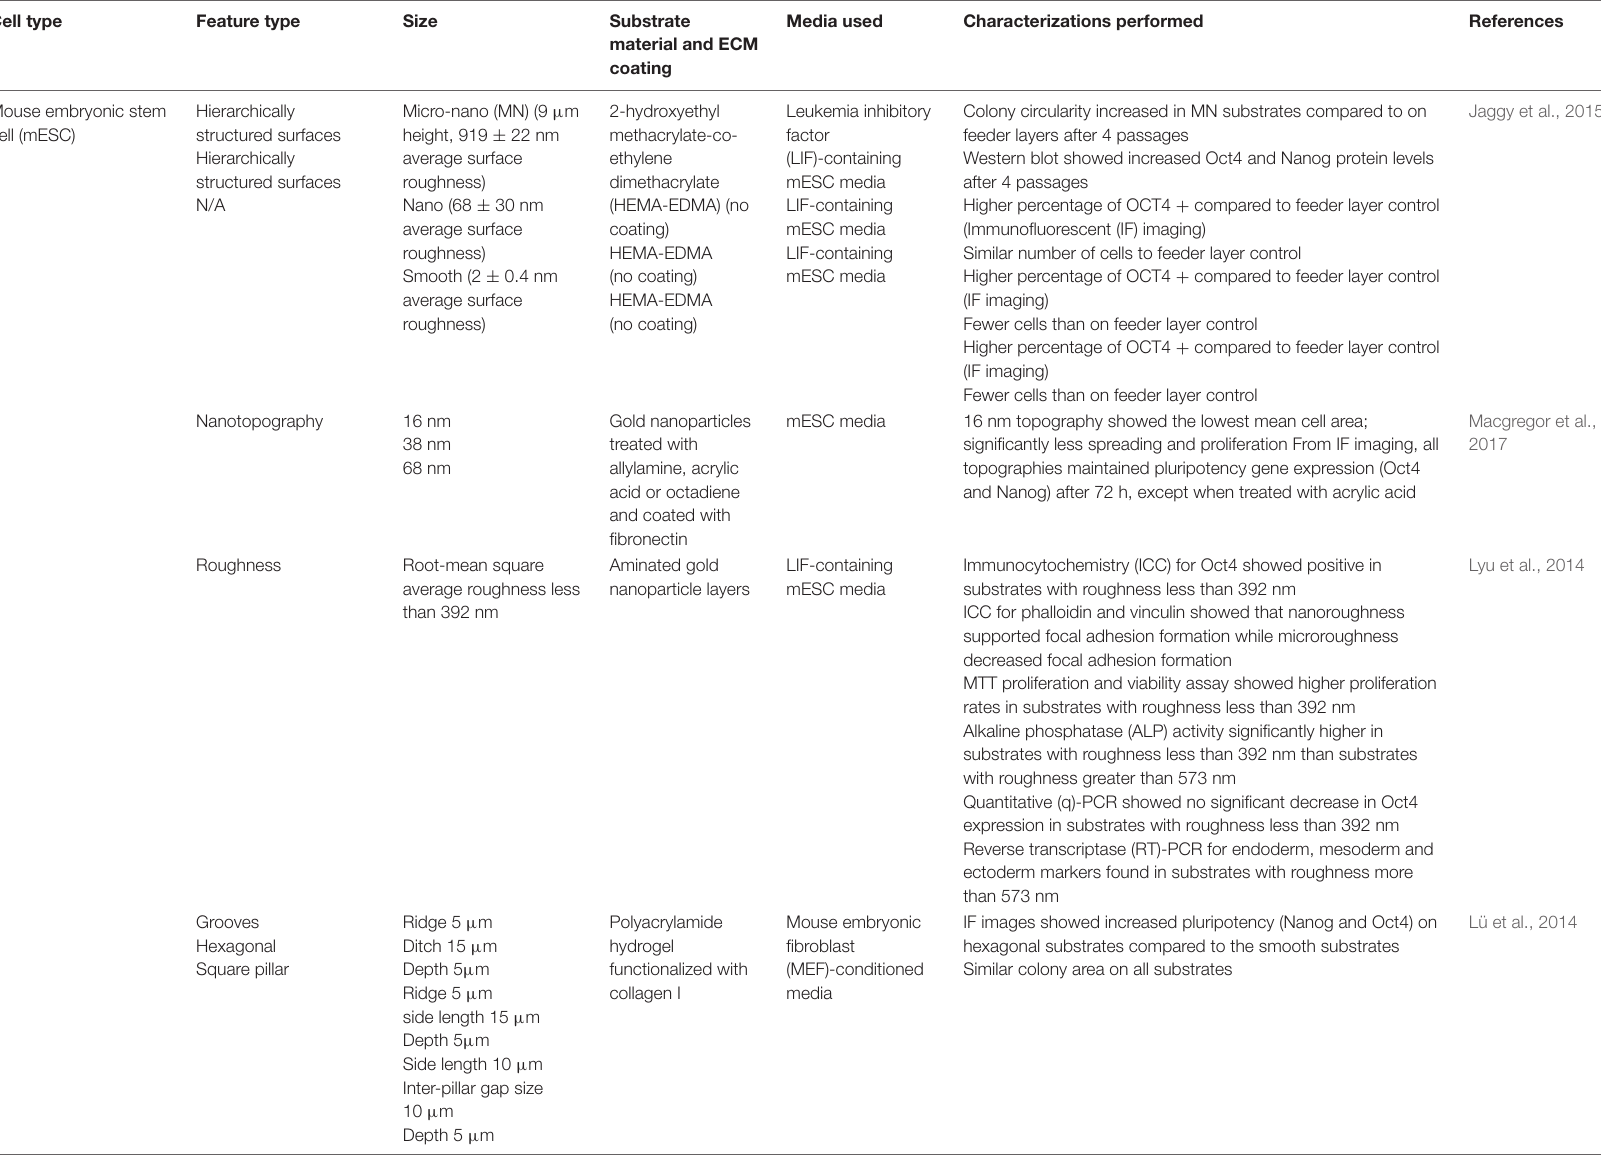
TABLE 2 | Summary of examples of studies of human or mouse pluripotent stem cells (hPSCs and mPSCs, respectively) on topographical features and their results. Cell